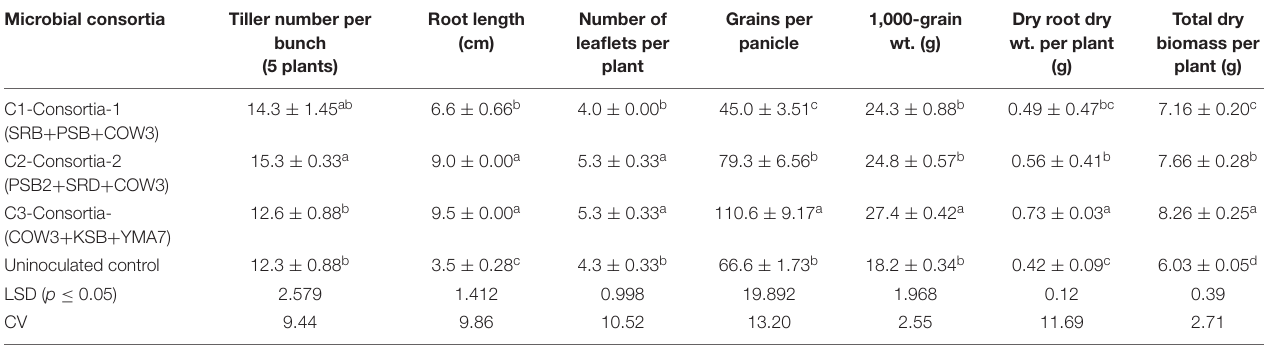
Root length Number of Grains per 1,000-grain bunch (cm) leaflets per panicle wt. (5 plants)